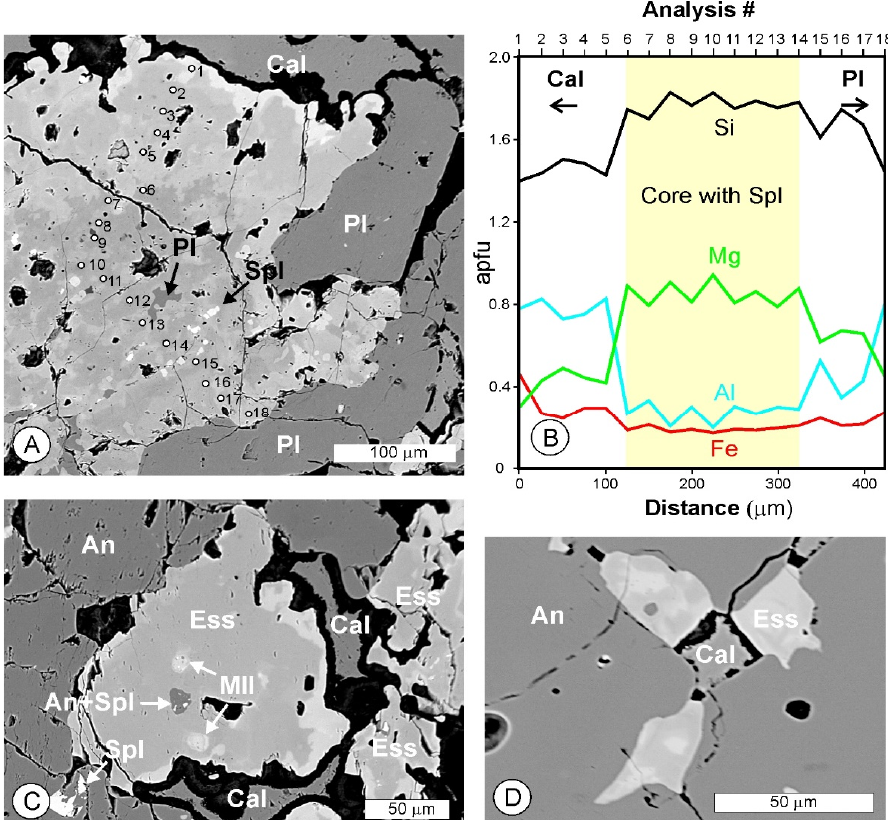
Figure 8. ( A ) Zoned Al,Fe 3+ pyroxene in contact with calcite and anorthite, showing esseneite margins and diopside core with abundant spinel inclusions. The measured EPMA profile ( B ) and the irregular domain zoning is reminiscent of a diffusion pattern. Note also the Fe-rich zone at the contact with calcite missing along the pyroxene-anorthite interface; ( C ) Melilite and anorthite+spinel inclusions in esseneite grain attached to calcite in anorthite layer. Esseneite has Fe 3+ -enriched margins along the contact with carbonate; ( D ) Inverse zonation pattern with bright esseneite cores surrounded by more diopsidic rims. All photomicrographs refer to sample Ca-14. Mineral abbreviations